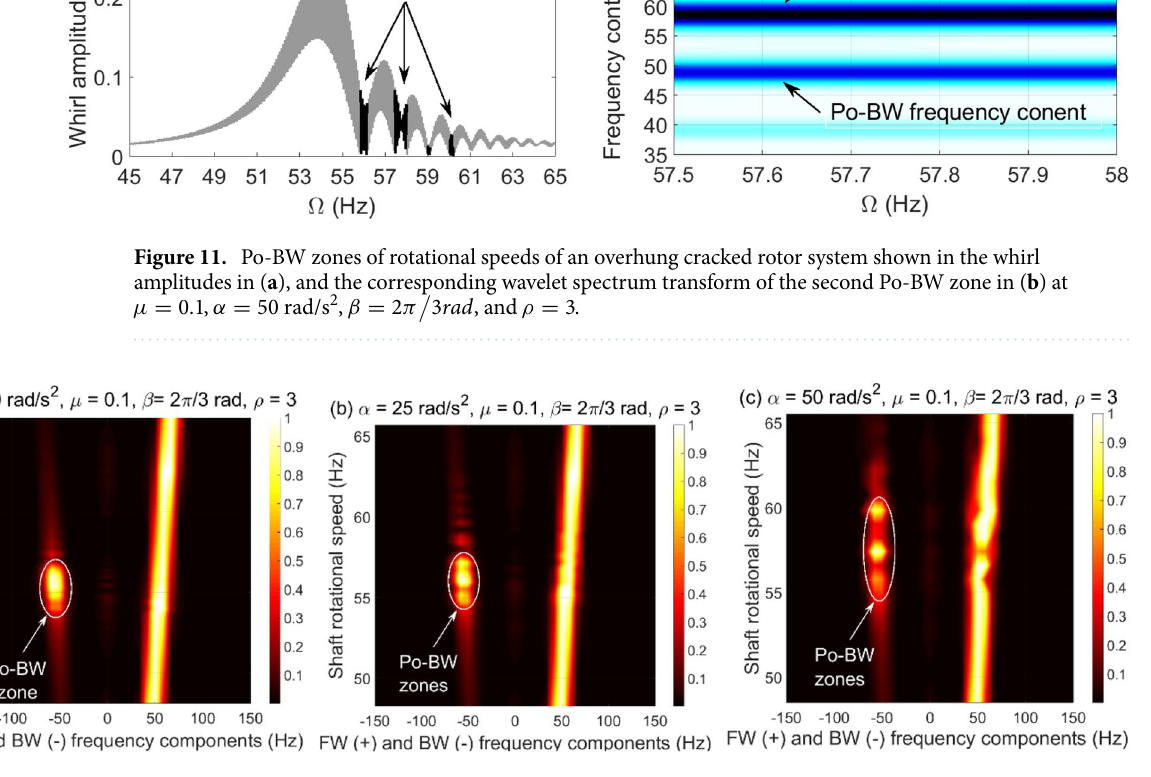
Figure 12. FSA plots for the Po-BW zones of rotational speeds at µ = 0.1 , β = 2 π α = 5 rad/s 2 , in ( b ) for α = 25 rad/s 2 , and in ( c ) for α = 50 rad/s 2